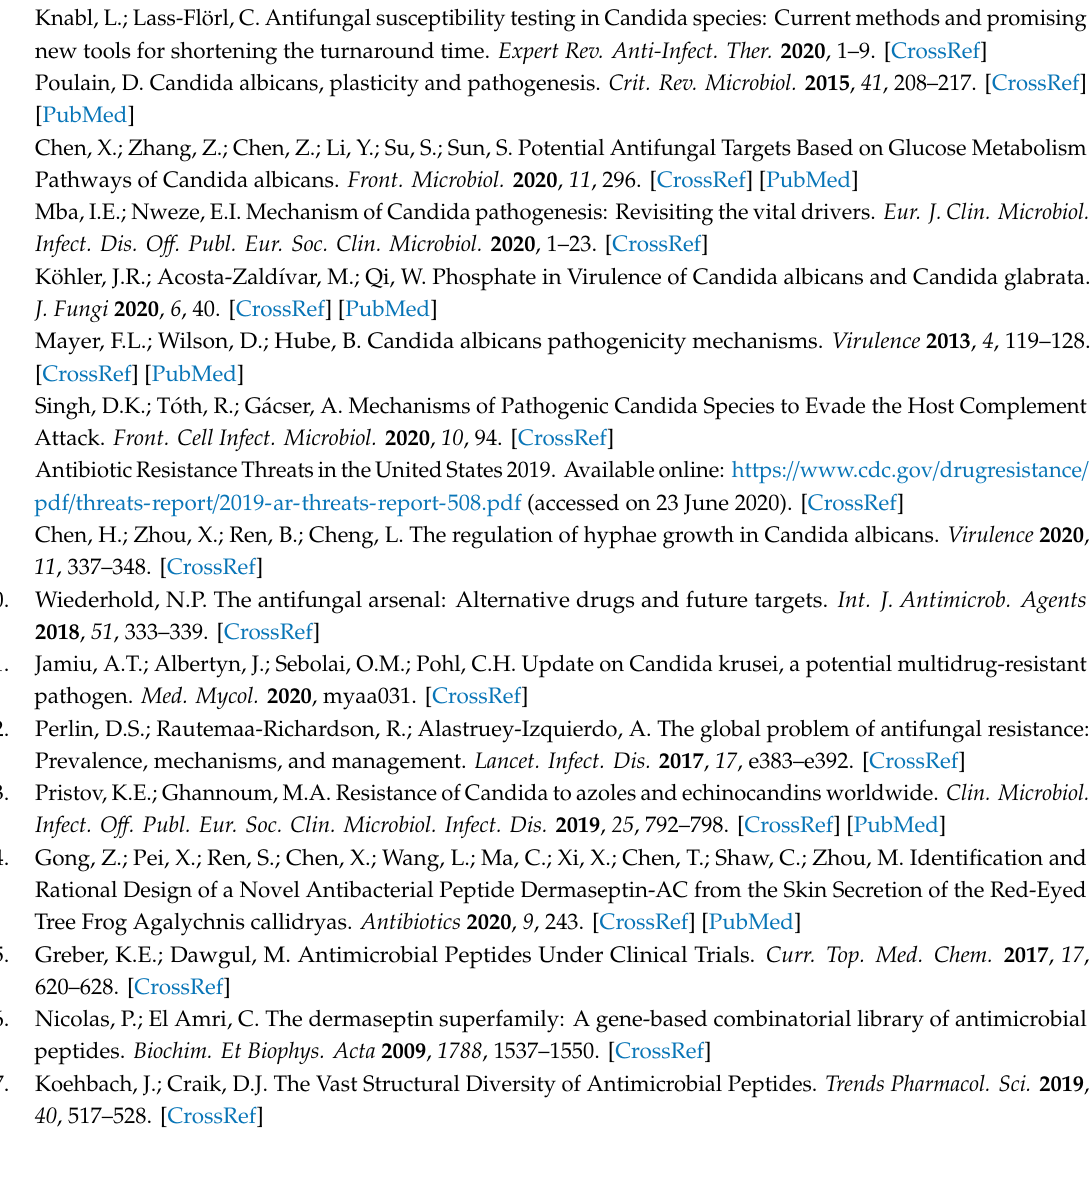
Figure S1: Accumulation of SYTOX ® Green in cells with disrupted membranes provoked by pilosulin- and ponericin-like peptides, Table S1: Average cell size of Candida cells treated with pilosulin- (Dq-2562) and ponericin-like (Dq-3162) peptides, and peptide combinations with amphotericin